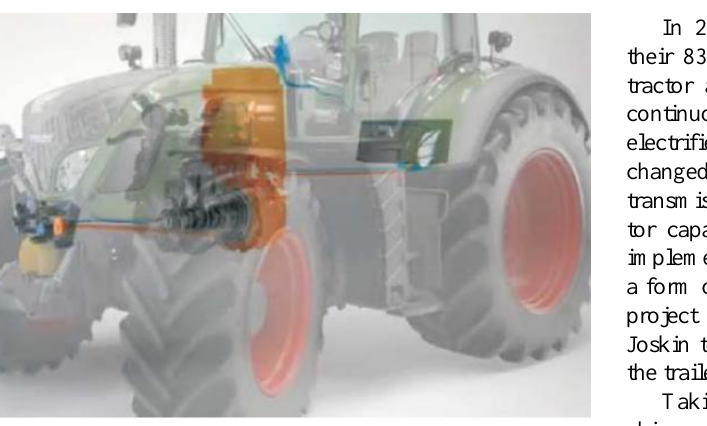
Fig. 17. Fendt X Concept powertrain components [15]